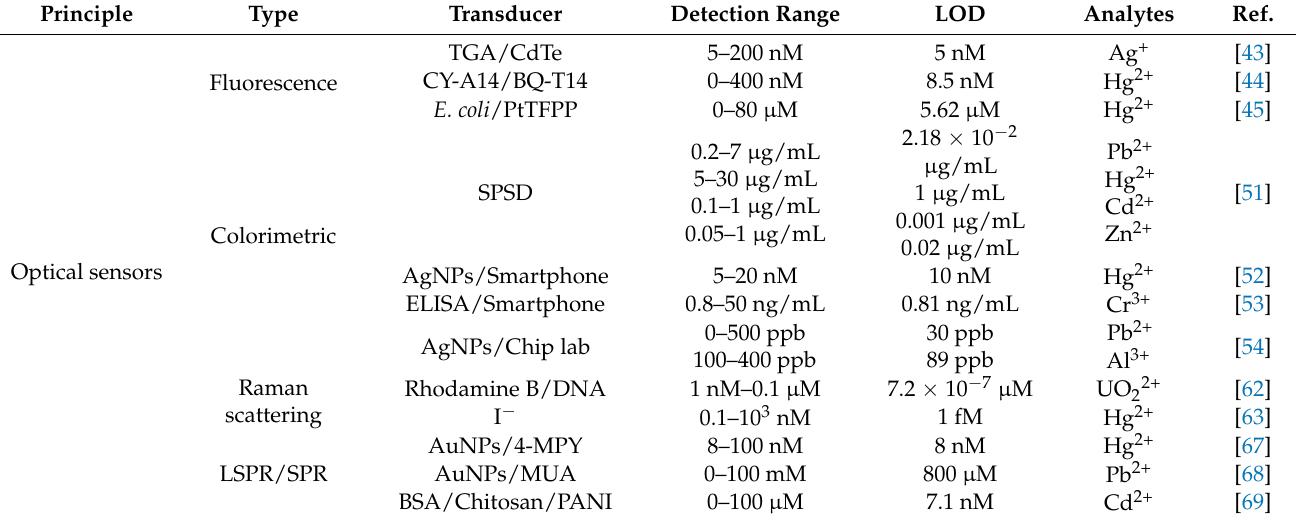
Table 1. Detection performance based on different principles.